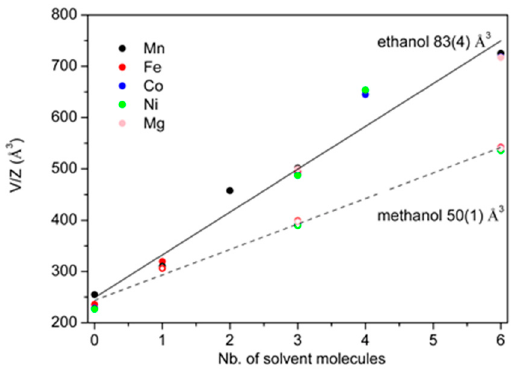
Figure 12. Experimental volume per formula unit (V / Z) as a function of number of ethanol or methanol ligands. The slope of the linear fit gives the average volume per solvent molecule.